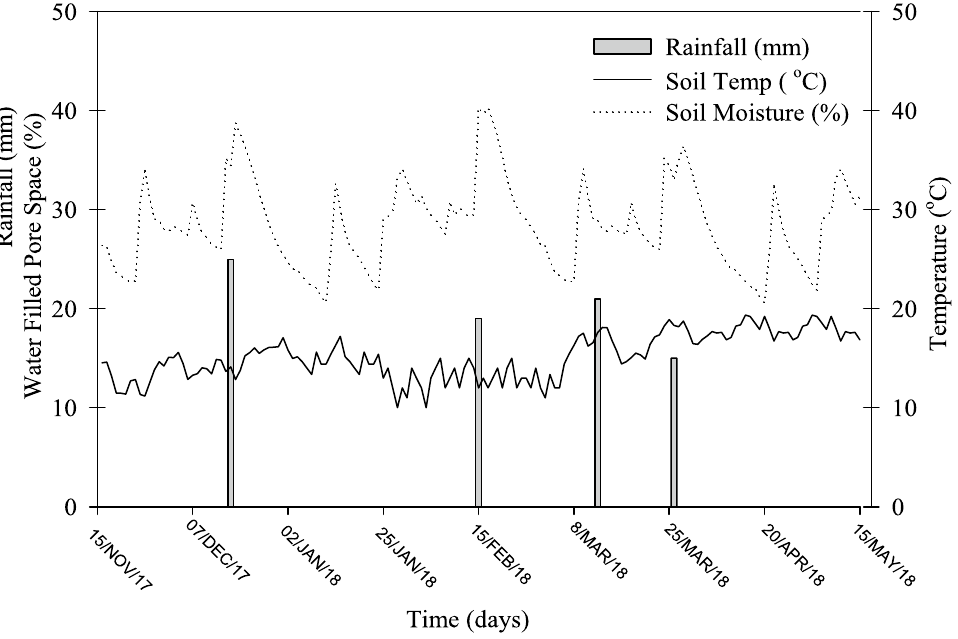
Figure 4. Soil (0–10 cm) temperature, moisture and precipitation throughout the growing